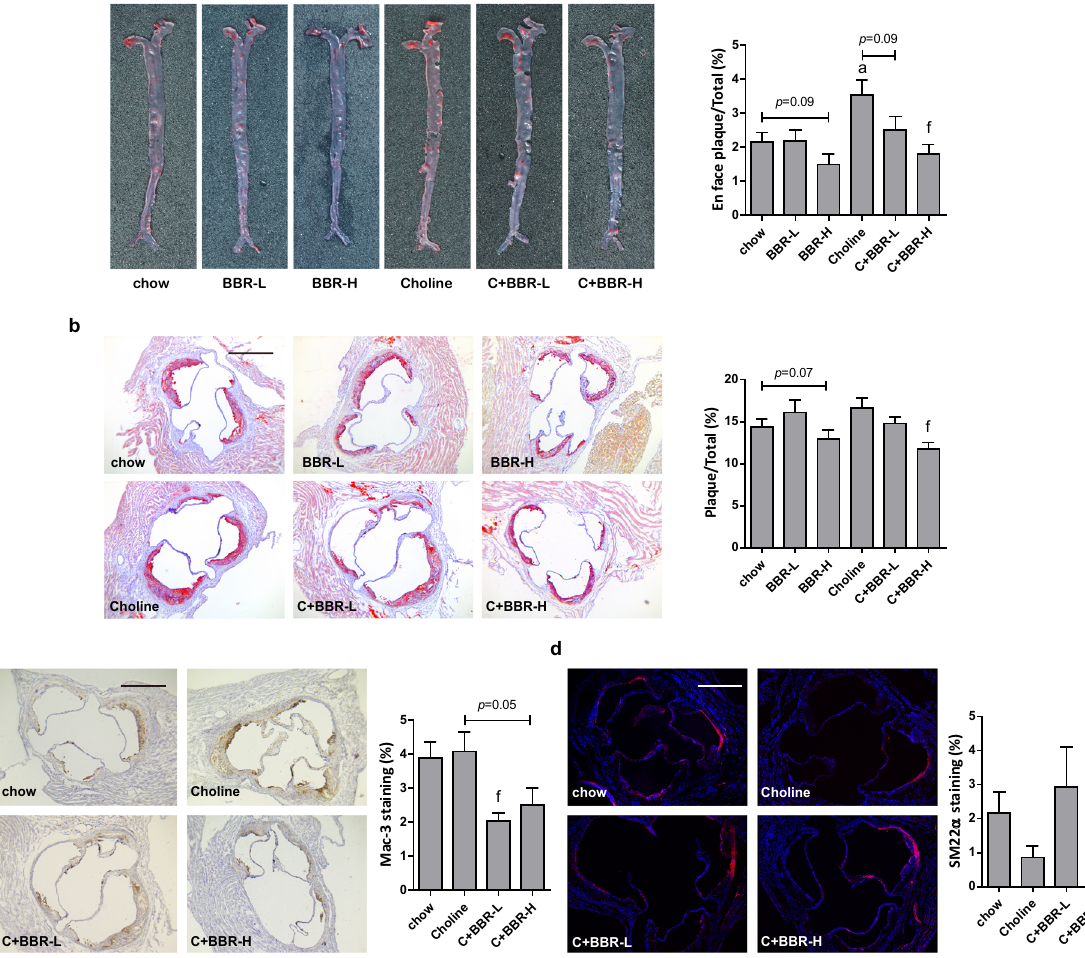
Fig. 3 BBR protected ApoE KO mice from choline-induced atherosclerosis. Eight-week-old female ApoE KO mice ( n = 10 per group) were fed with chow diet or choline diet in the absence or presence of 100 mg/kg BBR (BBR-L) or 200 mg/kg BBR (BBR-H) for 4 months. Atherosclerotic plaques in the whole aortas including the aortic arch, thoracic and abdominal regions ( a ), and aortic root ( b ) was assessed by Oil Red O staining, and the plaques area were quanti fi ed by ImageJ. c , d Immunostaining and fl uorescence microscopy were applied to analyze the area of Mac-3-positive macrophages ( c ) and SM22 α -positive smooth muscle cells ( d ) in the aortic root of ApoE KO mice. Scale bar = 500 μ m. Representative images are shown. Values are presented as means ± SEM ( n = 5 – 10). a p < 0.05 (versus chow-diet group); f p < 0.01 (versus choline-diet